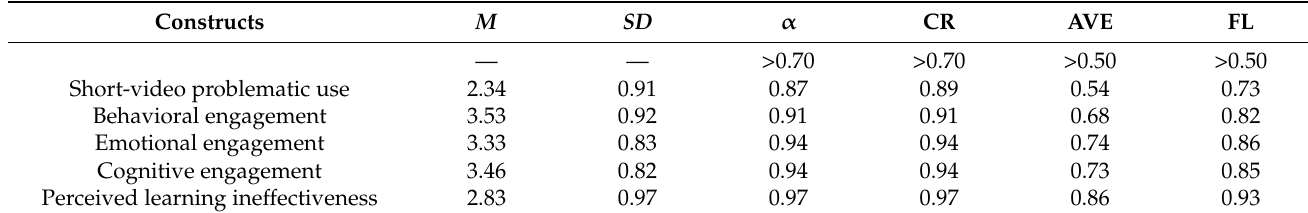
Table 2. Reliability and validity analysis.